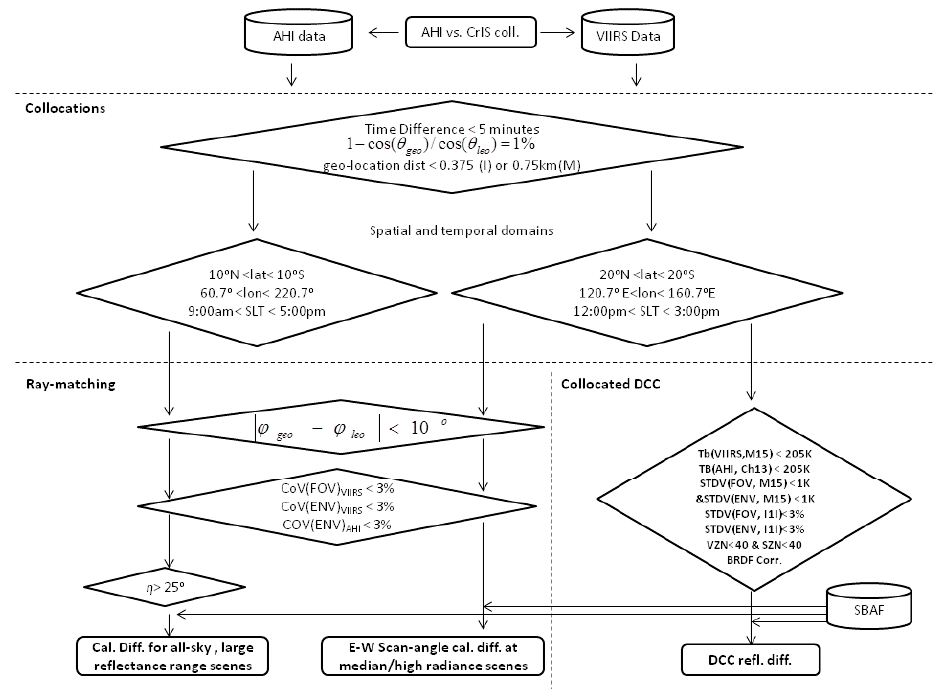
Figure 2. Flow-chart of AHI vs. VIIRS inter-calibration processes. The time and spatial location information of AHI and CrIS collocations are used to restrict the temporal and spatial searching domains. θ geo and θ leo are the GEO and LEO viewing zenith angles, respectively. ϕ geo and ϕ leo are the viewing azimuth angles for GEO and LEO instruments, respectively. η is the sun-glint